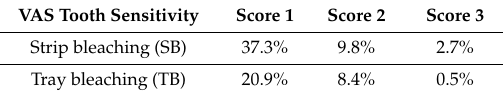
Table 2. Rossi et al. results